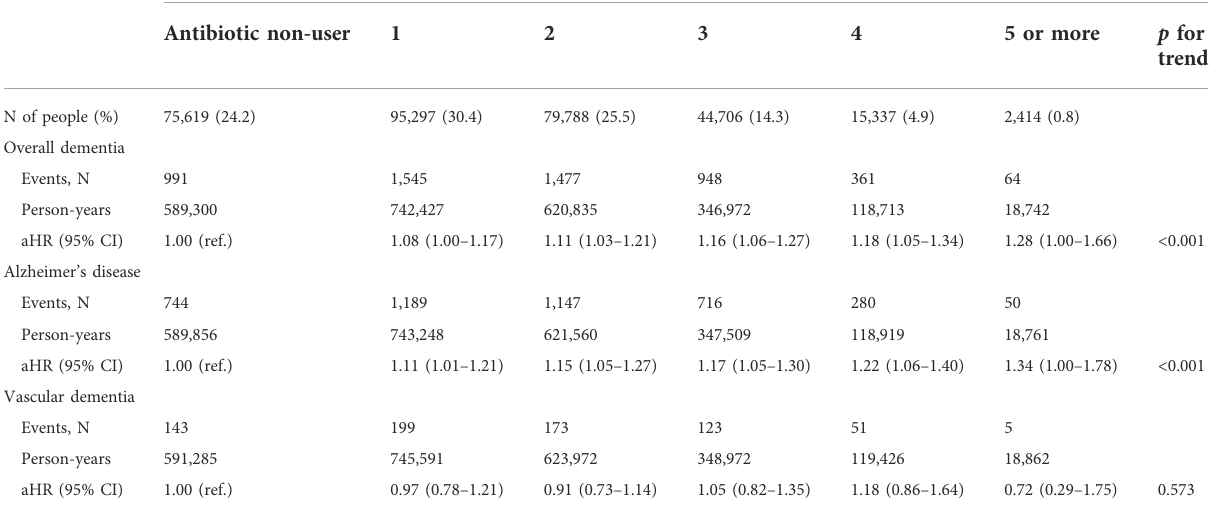
TABLE 4 Risk for dementia incidence according to the number of antibiotic